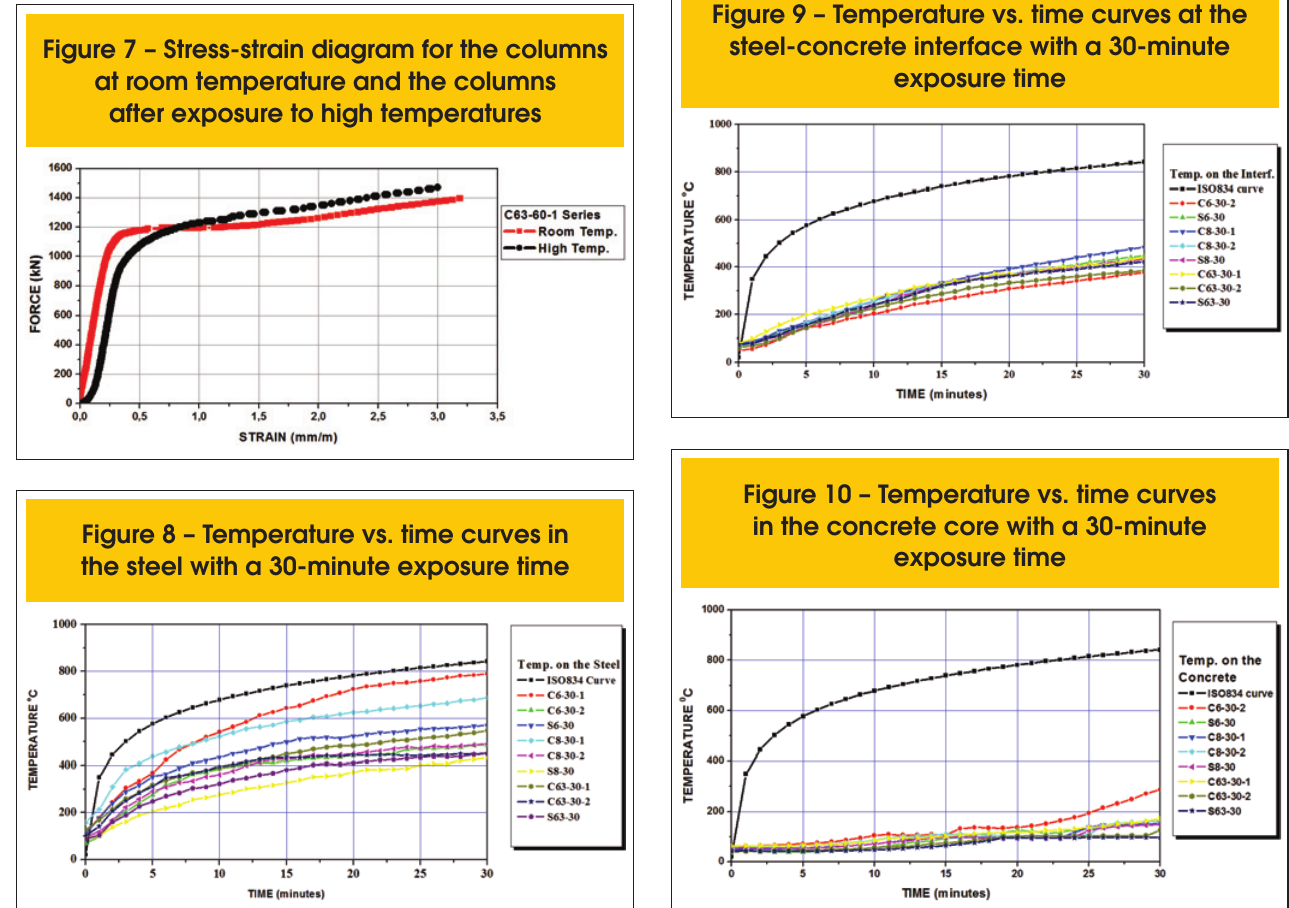
Figure 7 – Stress-strain diagram for the columns at room temperature and the columns after exposure to high temperatures